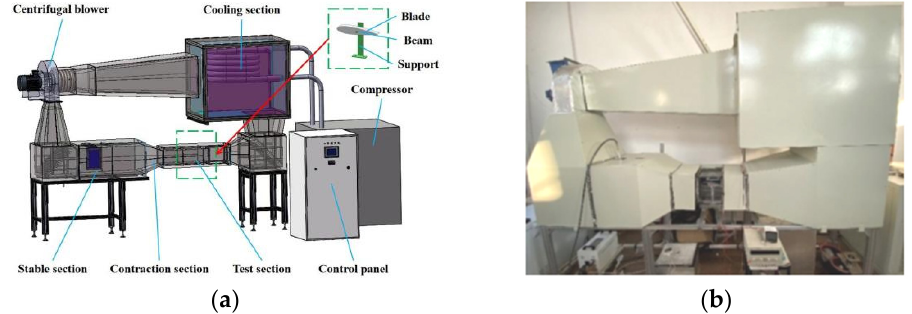
Figure 3. Icing wind tunnel test system ( a ) schematic diagram and ( b )